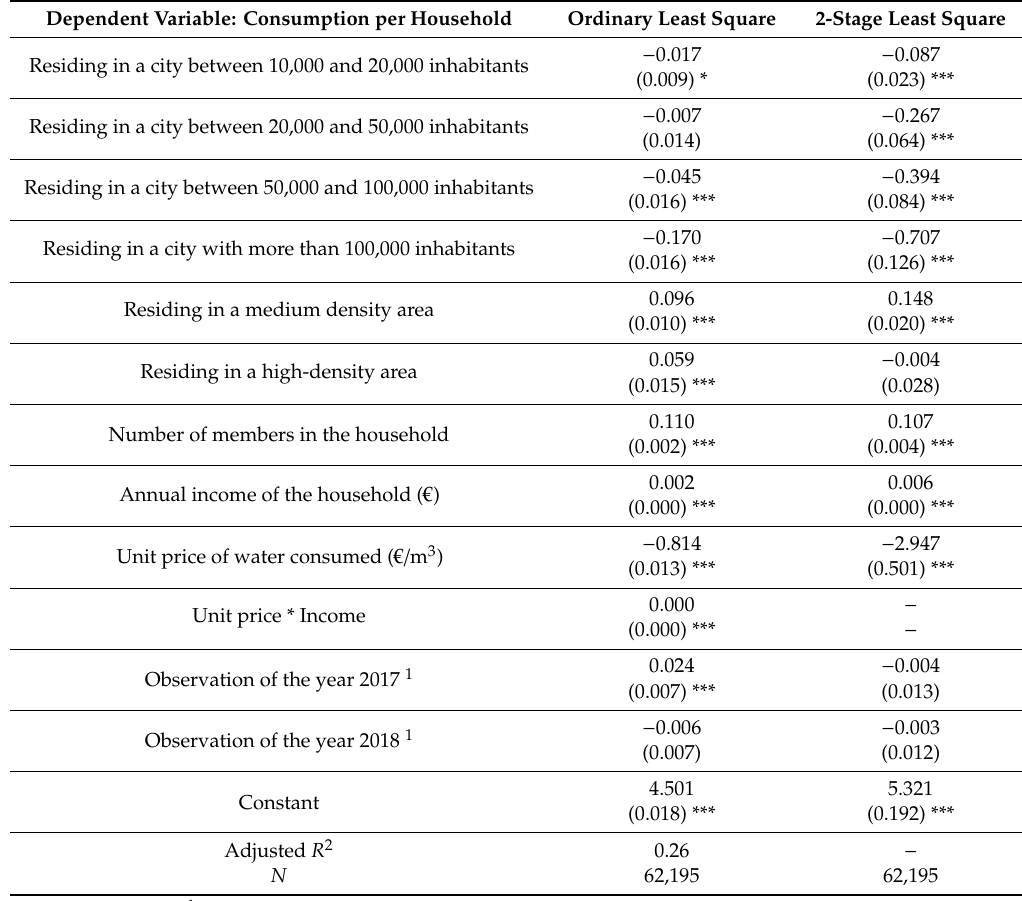
Table 1. Models with consumption per household as the dependent variable.